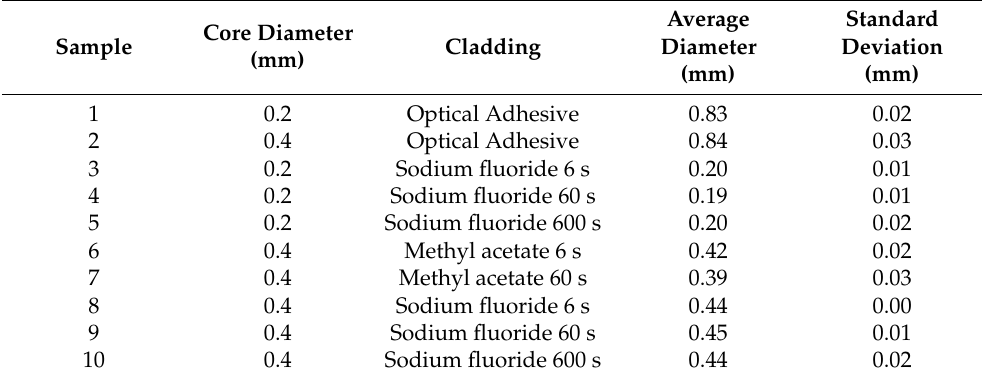
Table 2. Produced samples after cladding fabrication.